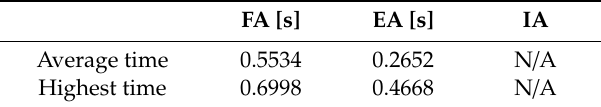
Table 3. The average and the longest traveling times of the ants in the approach without reservations